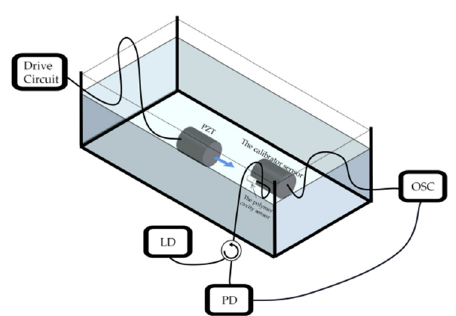
Figure 4. Schematic configuration of the experimental setup.